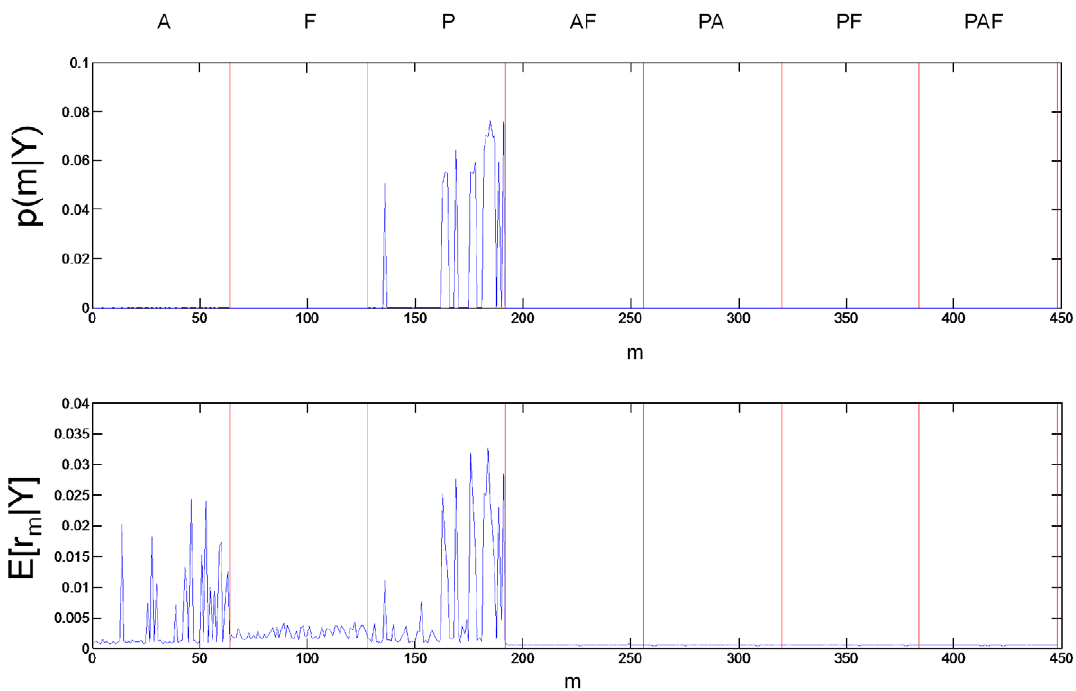
Figure 4. Model level inference for input families. For FFX (top panel) the figure shows that models in the P family have by far the greatest posterior probability mass. For RFX (bottom panel) models in both A and P families have high posterior expected probability, although the probability mass for P dominates.